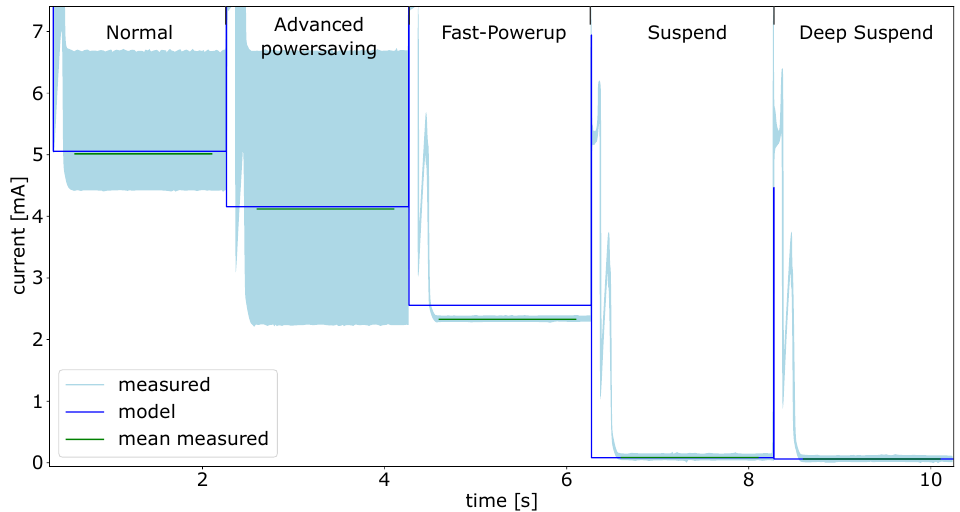
Figure 11. Gyro power modes model data and measured current values.